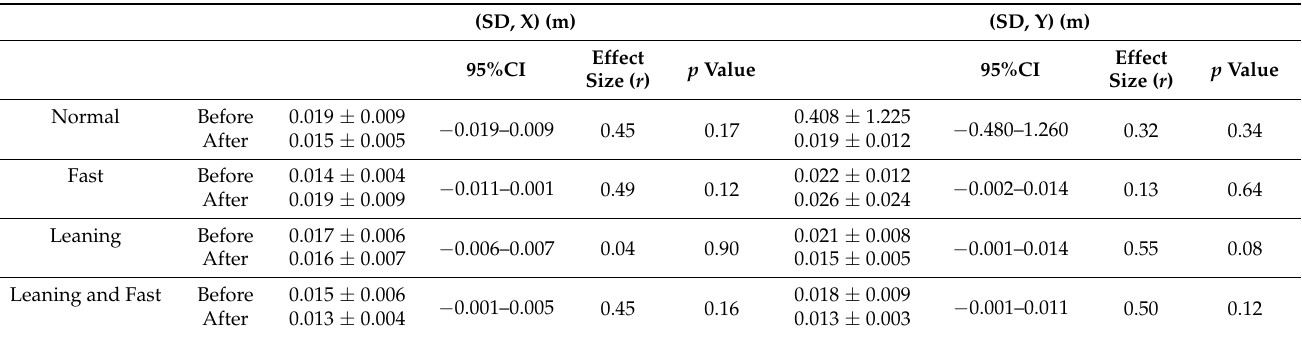
Table 10. Movement variation in the STG in anterior (SD, Y) and lateral (SD, X) direction of G-foot anterior obstacle